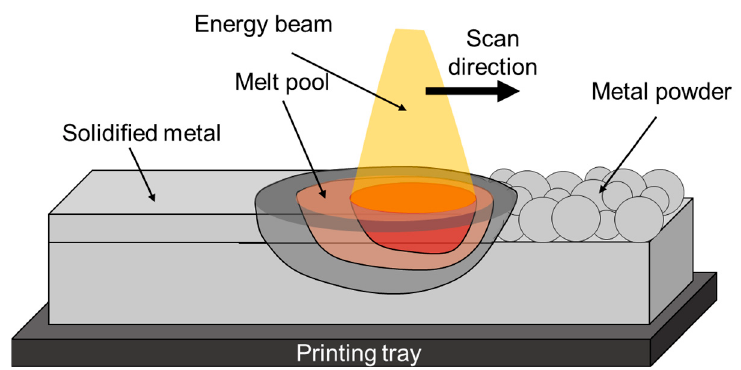
Figure 6. Schematic illustration of typical PBF